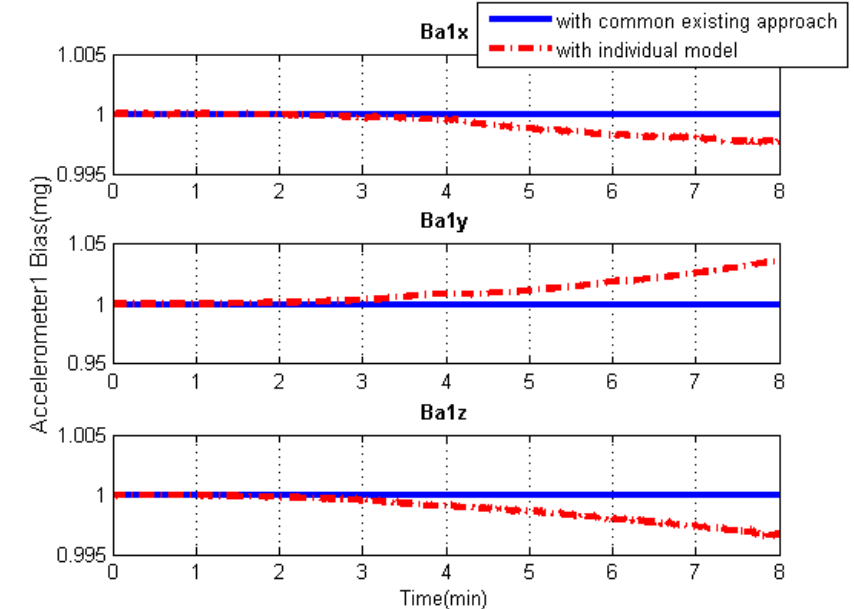
Figure 15. Accelerometer bias solution comparisons of the central IMU using the common existing approach or the individual modeling method.